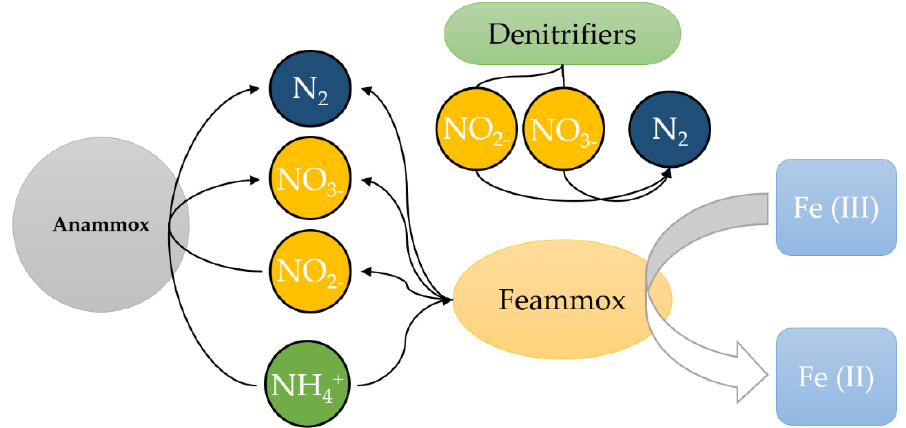
Figure 1. Illustrative diagram of the Anammox, denitrifiers, and Feammox process. The Feammox process has been shown to produce either N 2 , NO 2 − , or NO 3 − as the end-product in several environments, as shown in Equations (1)–(3) [18]. Among these reactions, the N 2 pathway is energetically more favorable than NO 2 − or NO 3 − pathways, and can occur over a wider range of conditions [22].